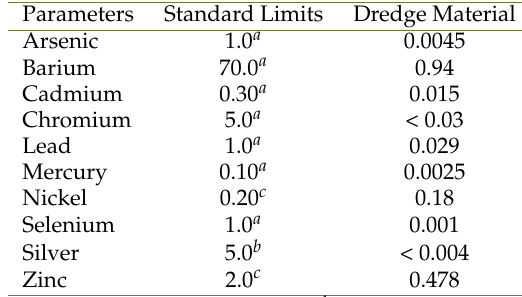
Table 5. TCLP result for the dredged material (ppm)